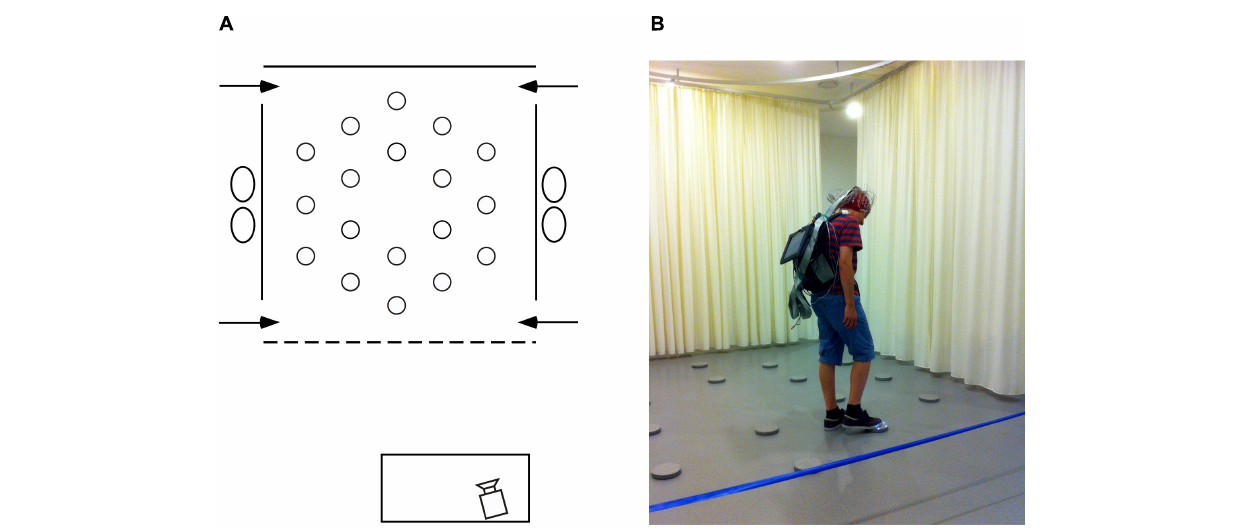
FIGURE 1 | Testing environment. (A) Schematic, aerial view of the arena (3.64 × 3.64 m) within the experimental room (8 × 8 m). At each of the four near and far corners of the curtained arena a 50 cm gap served as one of the four different entry points (arrows) through which participants must pass in order to enter and exit the testing arena. Eighteen foot pads were regularly arranged on the floor of the arena. (B) Picture of the arena with a participant carrying the EEG recording system and touching an illuminating foot pad during the allocentric spatial working memory